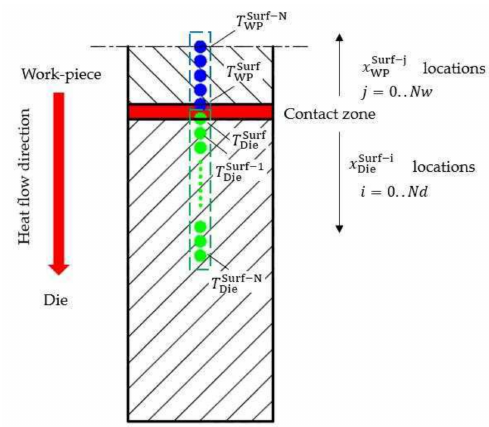
Figure 4. Simplified 1D heat transfer finite difference method for the work-piece and die with different initial